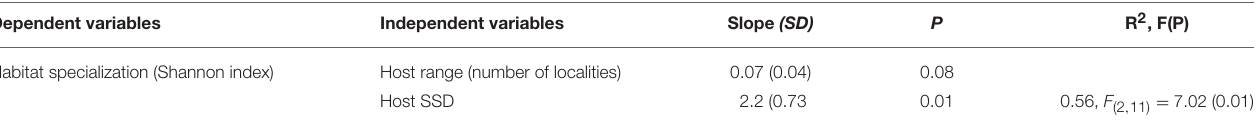
TABLE 6 | Best model explaining habitat specialization (Shannon index) in rodent species using independent contrasts (initial model with host abundance, host range and host sexual size dimorphism) using the AIC criteria (with SD = standard deviation of the slope).